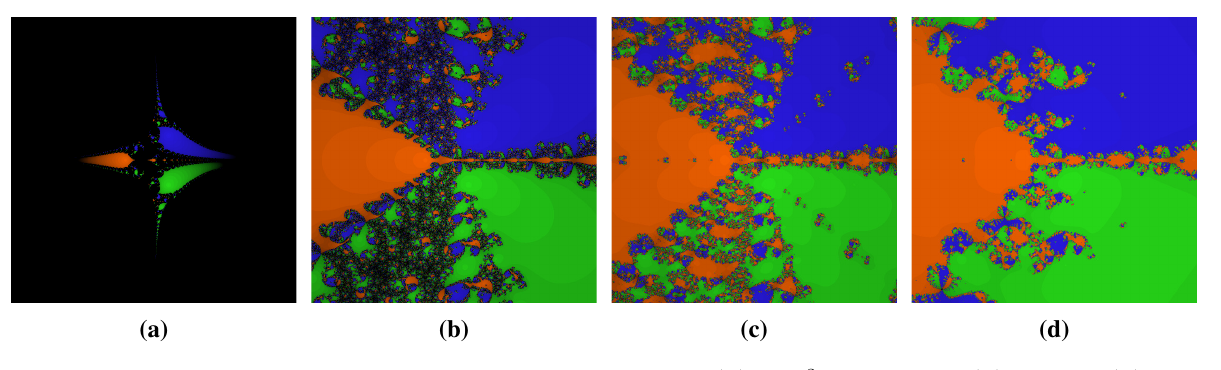
Figure 3. Dynamical planes of iterative methods on q ( z ) ; ( d ) X ( c ) E q 1